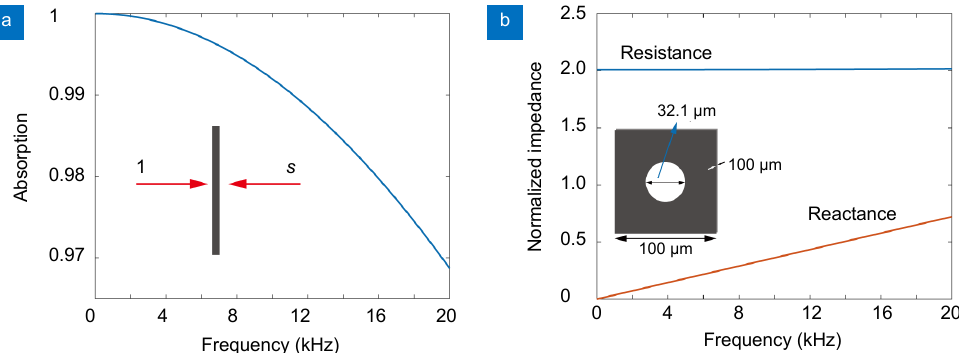
Fig. 6 | Acoustic coherent perfect absorber. ( a ) Absorption spectra of the coherent perfect absorber. ( b ) Normalized impedance at different